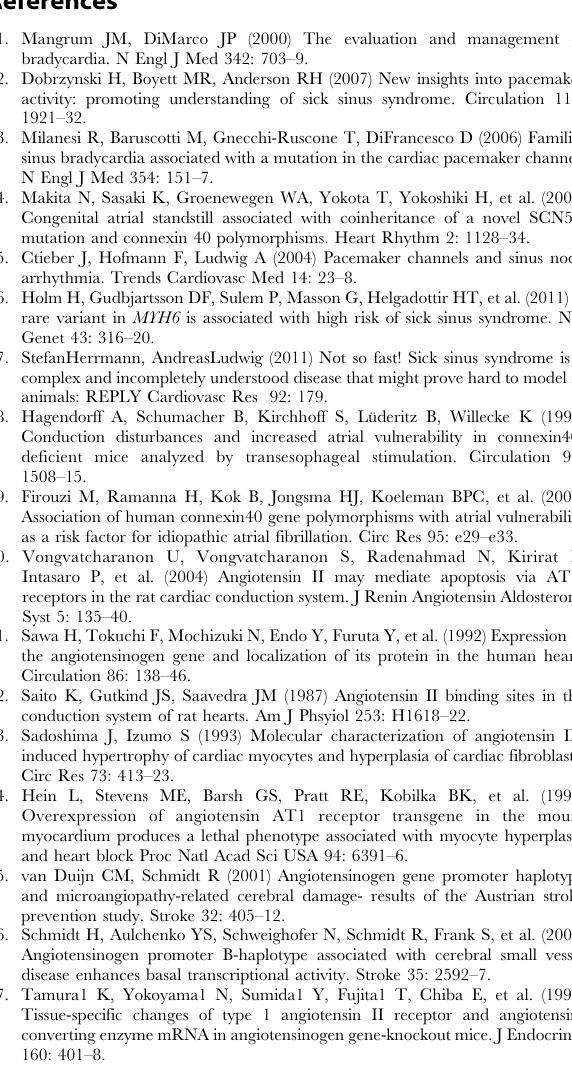
Figure S1 AGT A-20C genotyping by direct sequencing. The arrows indicate the polymorphic sites of AA, AC and CC genotypes. Figure S2 AGT G-152A genotyping by direct sequencing. The arrows indicate the polymorphic sites of GG and AG genotypes.